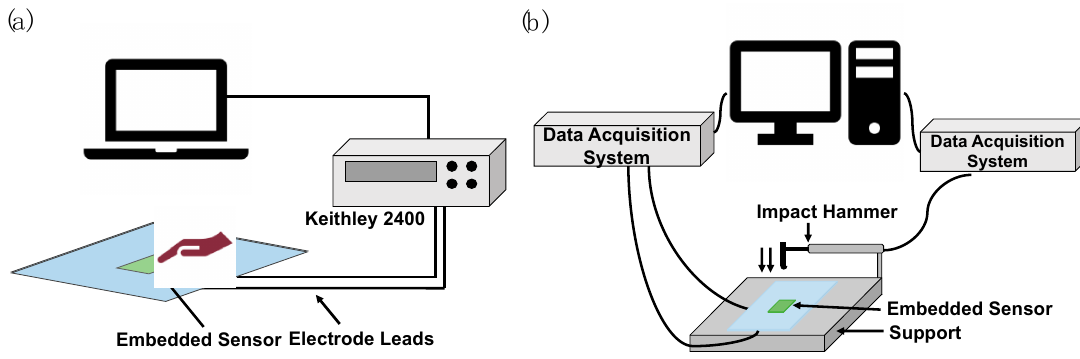
J. Compos. Sci. 2020 , 4 , x FOR PEER REVIEW Figure 7. Schematics of the ( a ) tapping and ( b ) impact hammer experiment. Figure 7. Schematics of the ( a ) tapping and ( b ) impact hammer experiment.